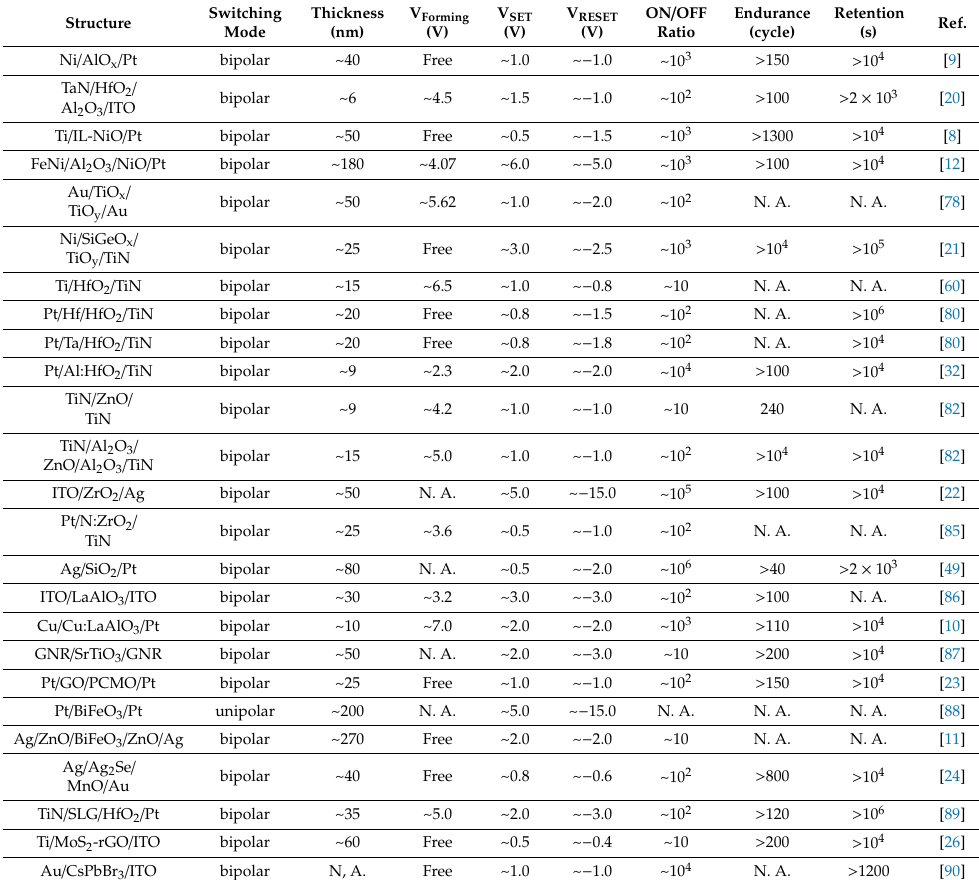
Table 1. Performance comparison among RRAM devices with various binary and complex oxides (metal and nonmetal